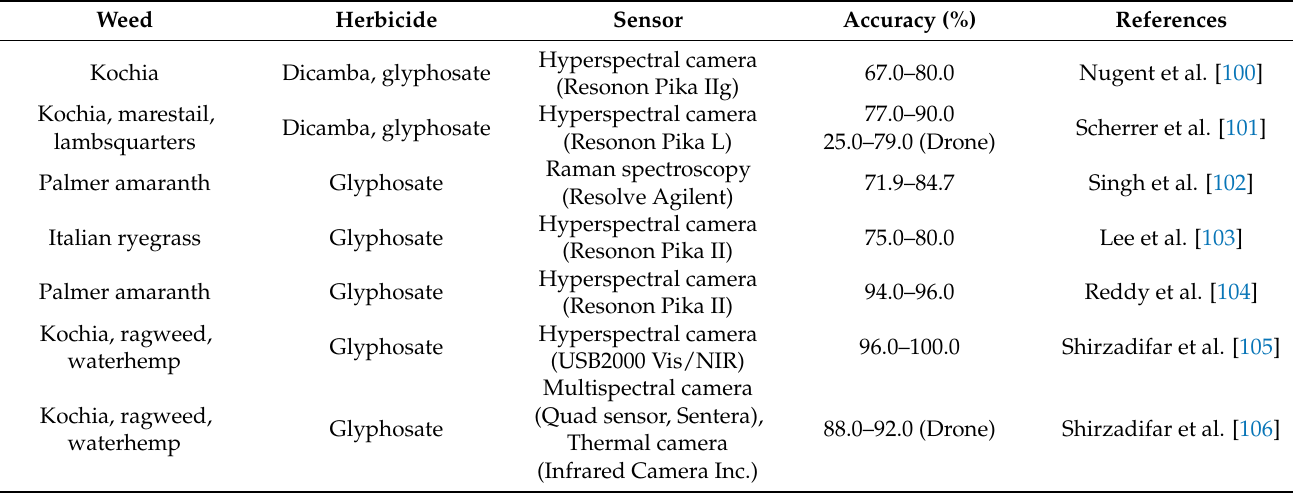
Table 3. Spectral sensors for herbicide-resistant weed